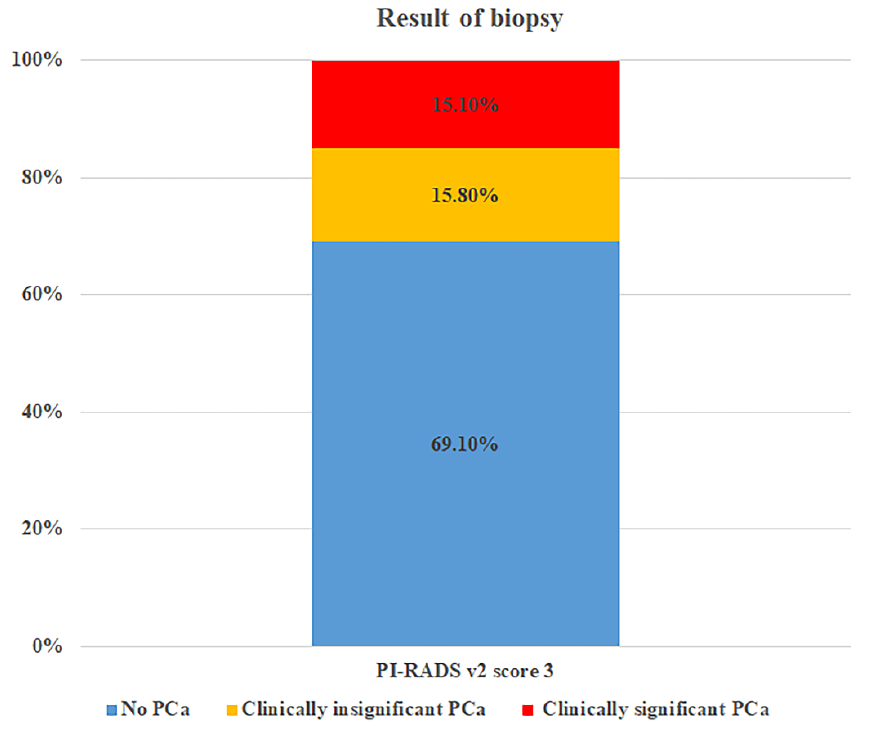
Figure 2. Pathologic outcomes of PI-RADS v2 score-3 lesions, as assessed by cognitive, TRUS- targeted